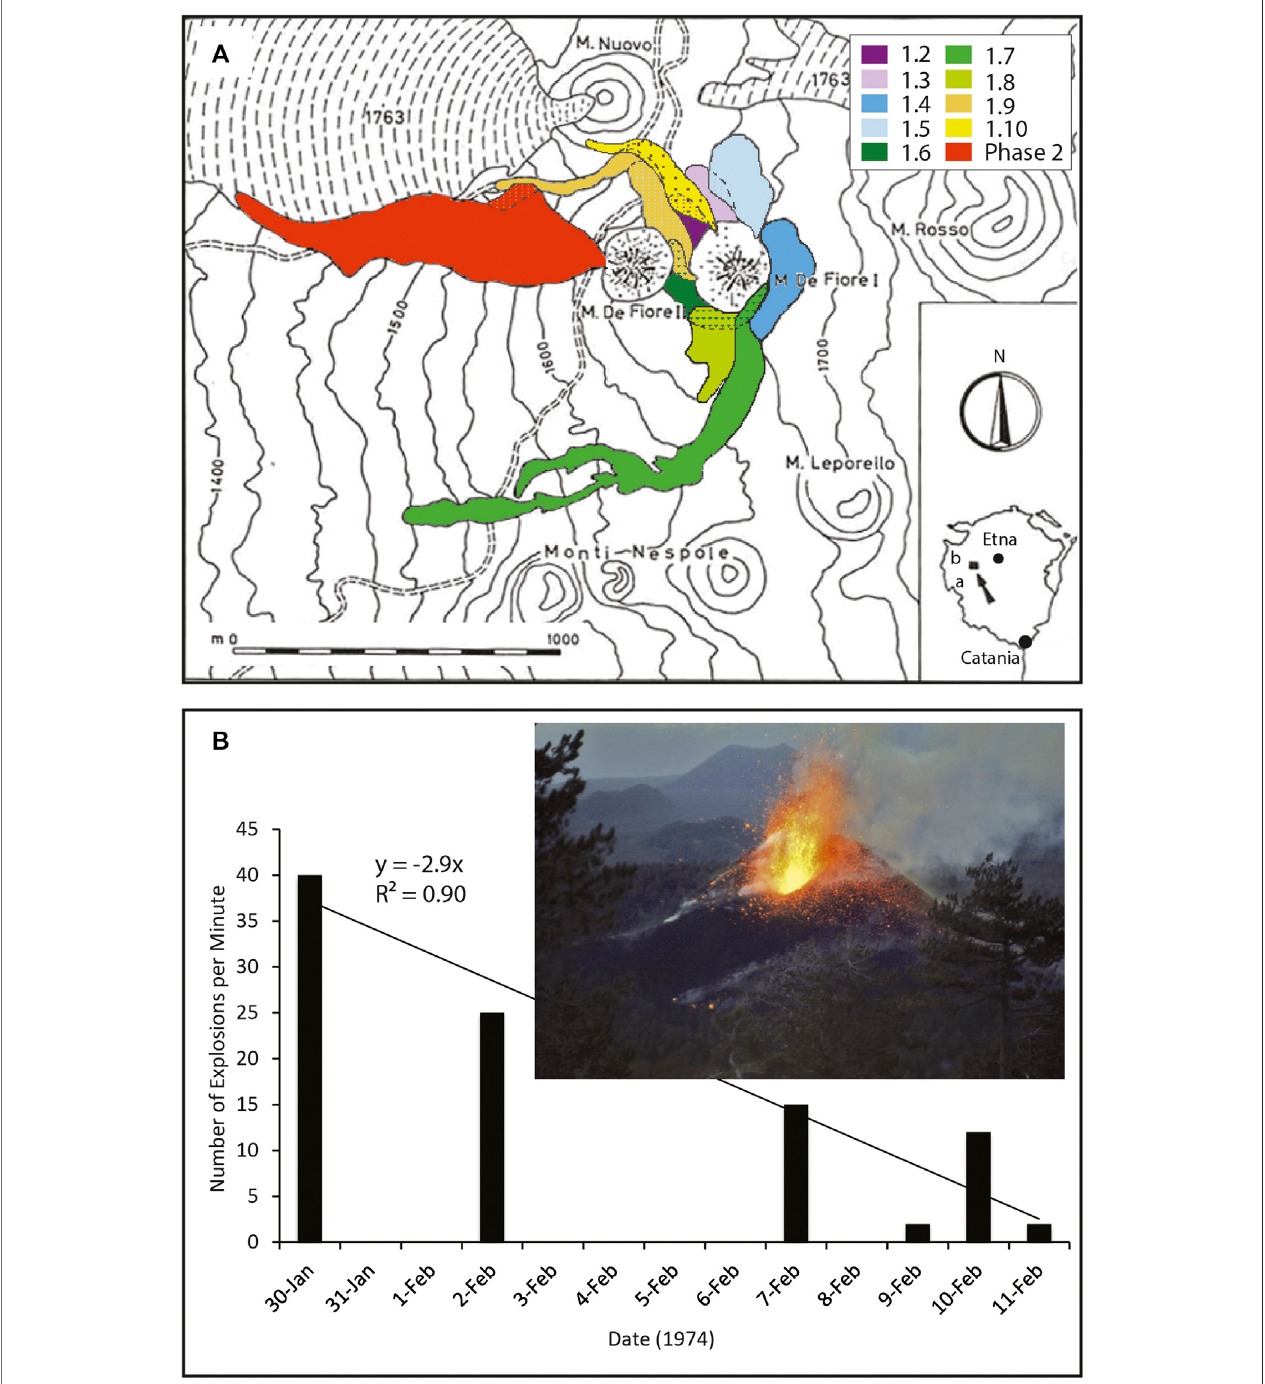
FIGURE1|(A) Original fl ow fi eldmapoftheJanuary – March1974west fl ankeruptionatMountEtnawiththeconesbuiltduringphasesIandII(labeledM.deFioreI and II, respectively),asmodi fi edfrom Bottari et al. (1975).Eight ofthe tenlava fl owunits from PhaseIare givenascoloredfollowingthenew mapping given heretoallow comparison.Onelava fl owunit(i.e.1.1representedbybrowndots)wasburiedbysubsequentlava fl ow,andsoisnotmappedbyBottarietal.(1975).Thedarkblueunit (1.4)oftheBottarietal.(1975)mapisthedepositfromacollapseofthewest fl ankofM.deFioreIthatburiedlavaunit4.AccordingtothemapofGuestetal.(1974), these were “ two short, thick, viscous fl ows (that) erupted from boccas on the eastern side of the cone ” . The lava fl ow fi eld from M. de Fiore II is in red. On the inset, the letters “ a ” and “ b ” mark the approximate locations of the towns of Adrano and Bronte, respectively. The edge and the parts of buried lava fl ows are represented respectively by dots and dashed lines of the color associated with each unit. (B) Explosion frequency during Phase I from data in Guest et al. (1974). Inset is a color version of the black and white photo of activity at M. de Fiore I given in Tanguy and Kieffer (1976). The photo was taken on the evening of February 3, 1974, and view is north toward M. Nuovo which is silhouetted on the skyline in the background. The eruptive cone is 70 m high, and the height reached by incandescent bombs in this explosive event captured by Tanguy and Kieffer (1976) is also 70 m.